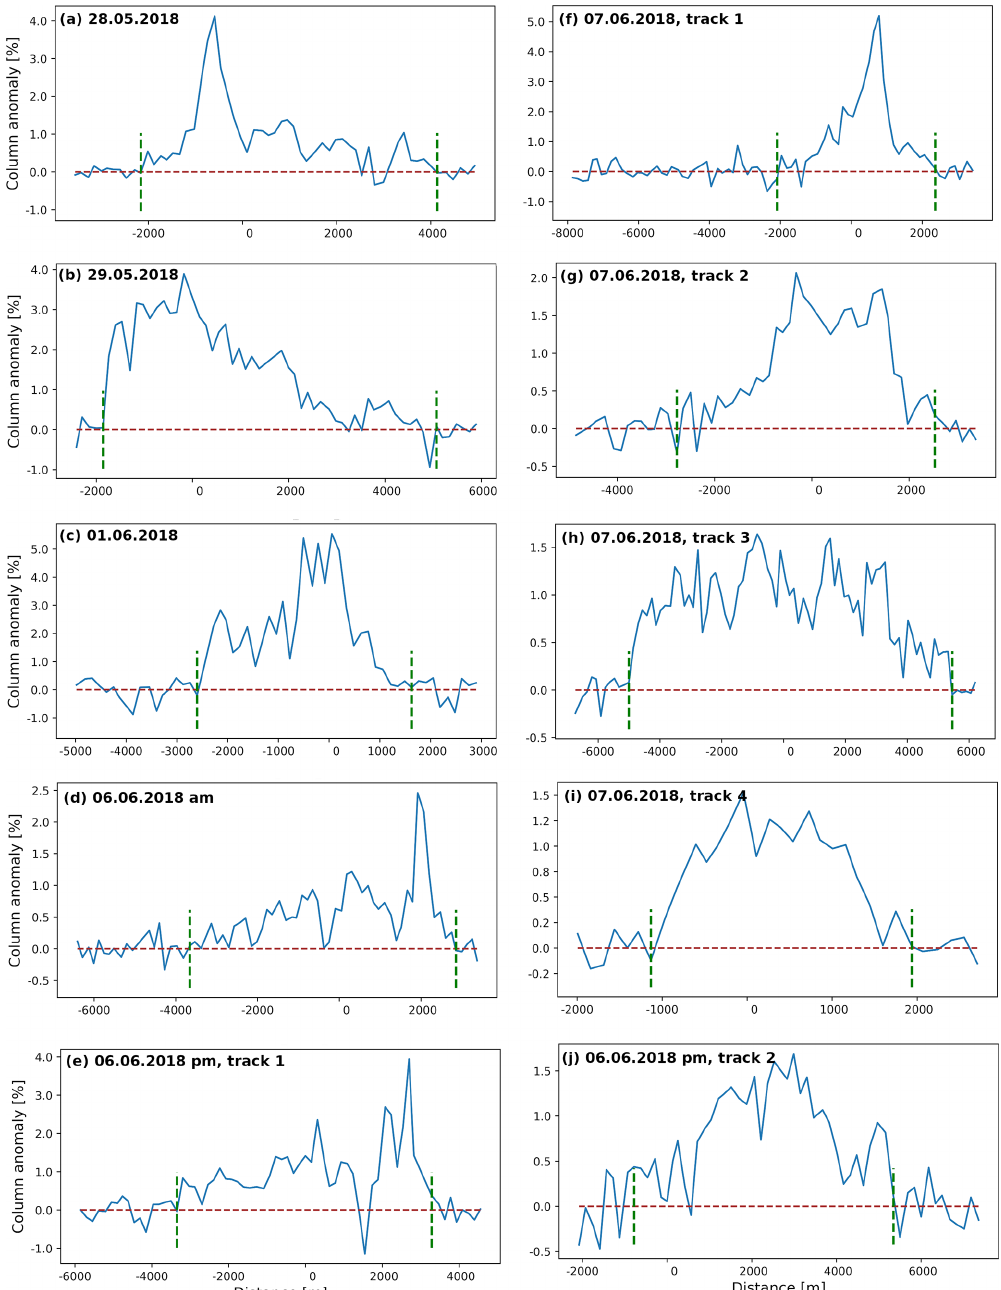
Figure C1. CH 4 anomalies along the cross-sections downwind of ventilation shafts of cluster b on the different flight days. Green vertical dashed lines separate the plume from the background area. A 2D visualization is shown in Fig.